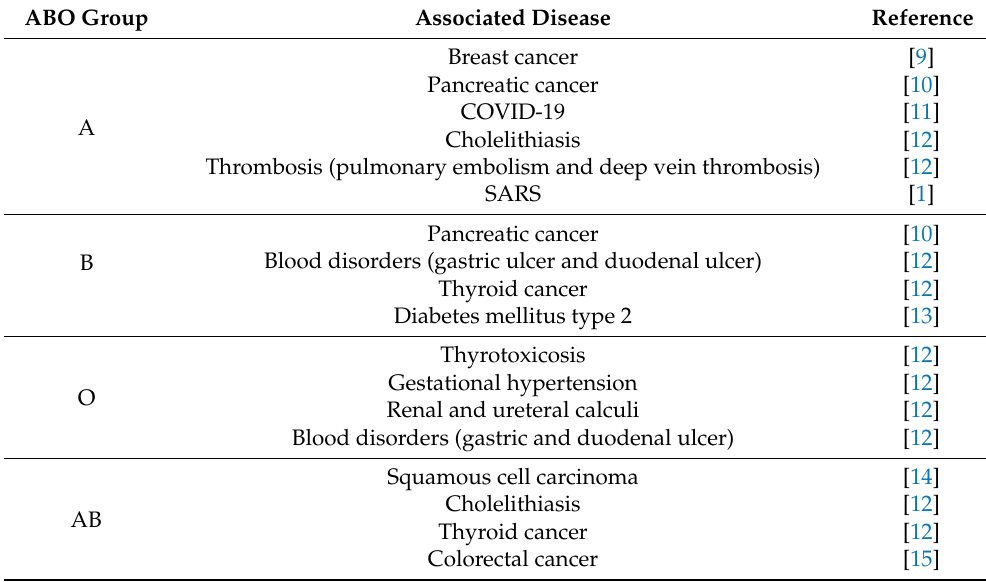
Table 1. Associations between the incidence of diseases with the blood groups of the ABO system.